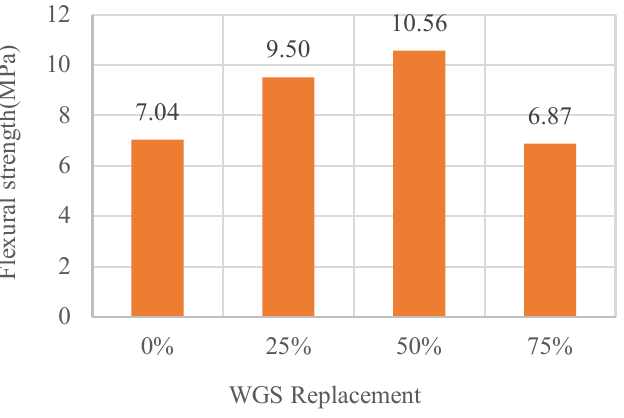
Figure 14. Split tensile strength at 28 days.